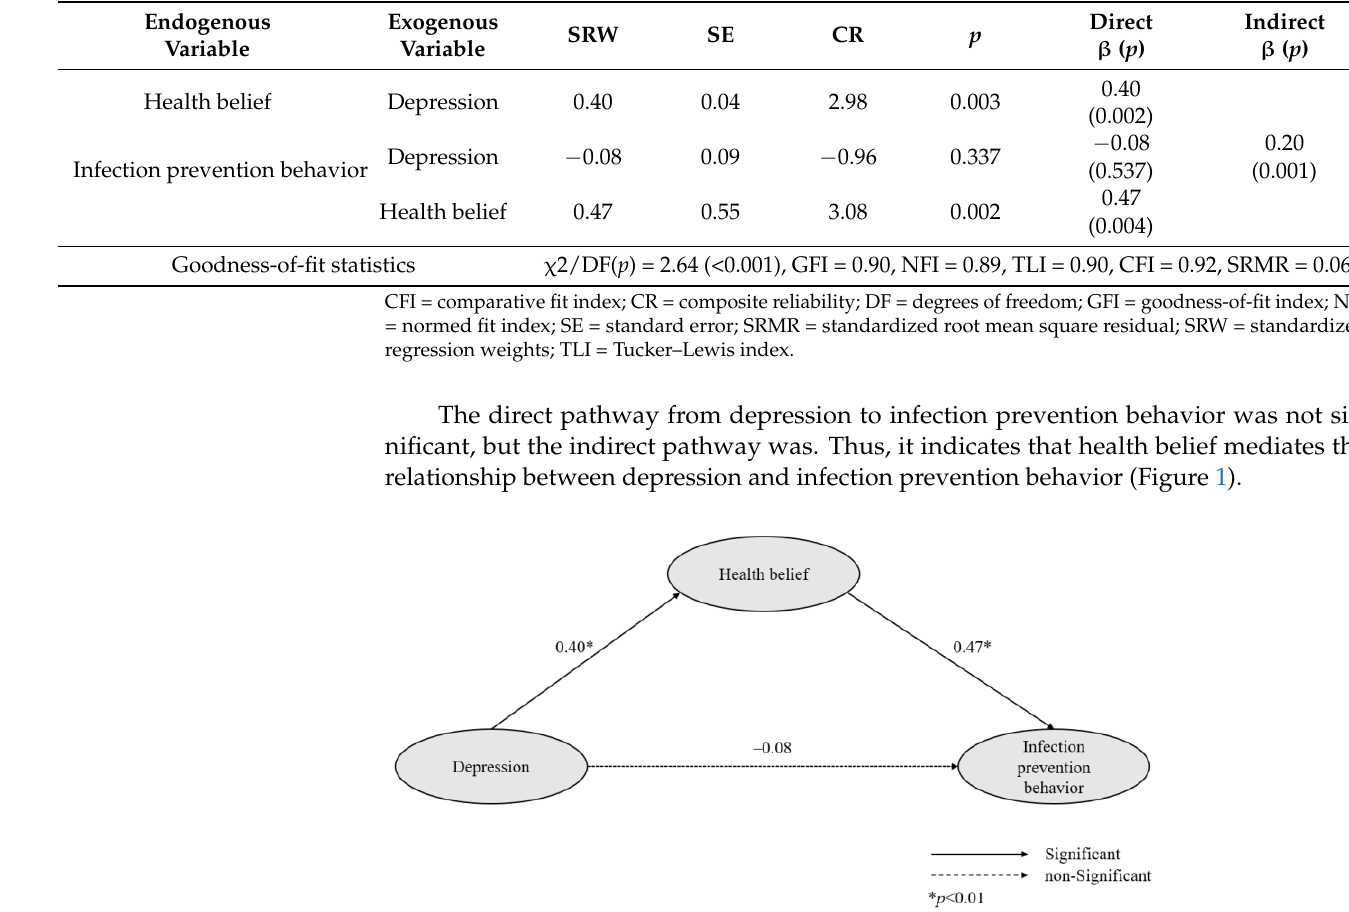
Table 3. Model fitness and path analysis.